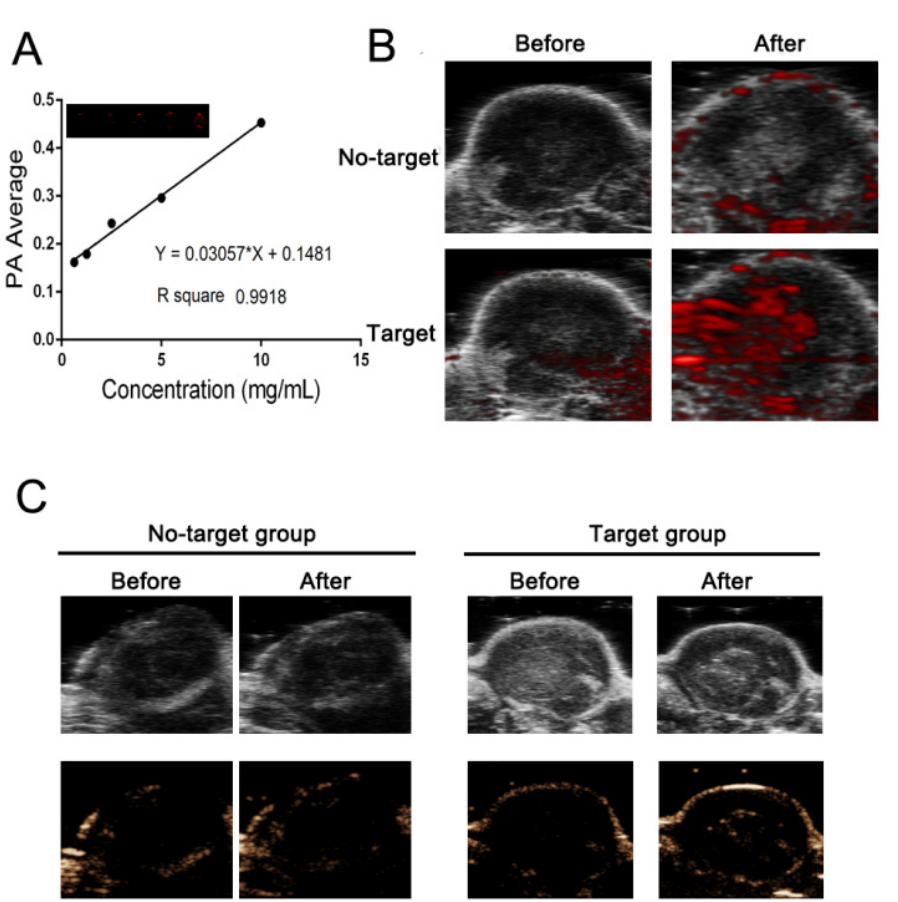
Figure 5. PA and ultrasound imaging in vivo: ( A ) Quantitative analysis of the relationship between the PA signal intensity and the nanoparticle concentration. ( B ) PA images of the tumor before and after nanoparticle injection. ( C ) US images in B-mode and CEUS mode of nanoparticles before and after LIFU irradiation.